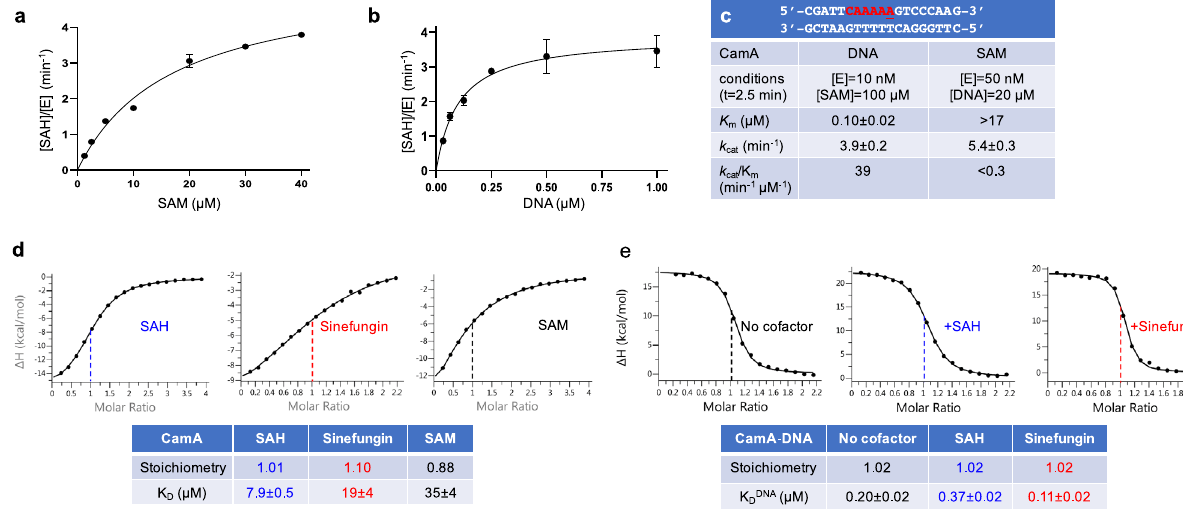
Fig. 1 Activity of CamA. a , b The formation of byproduct SAH was measured in a bioluminescence assay, by varying concentrations of methyl donor SAM ( a ) or substrate DNA ( b ) ( N = 2). The dependence of the velocity of product SAH formation per enzyme molecule [SAH]/[E] on substrate concentration was analyzed according to the Michaelis – Menten equation. c Summary of CamA kinetic parameters. The DNA substrate used is also shown. Data represent the mean ± SD of two independent determinations, with duplicates assayed for each of the two determinations ( N = 2). Source data are provided as a Source Data fi le. d ITC measurements of dissociation constants ( K D ) and stoichiometry of CamA for SAM, SAH, and sinefungin, with N number of independent determinations ( N = 3 for SAH, N = 2 each for SAM and sinefungin) (Supplementary Fig. 2). e In fl uence of cofactor on CamA-DNA binding dissociation (two independent determinations N = 2; Supplementary Fig. 3b,